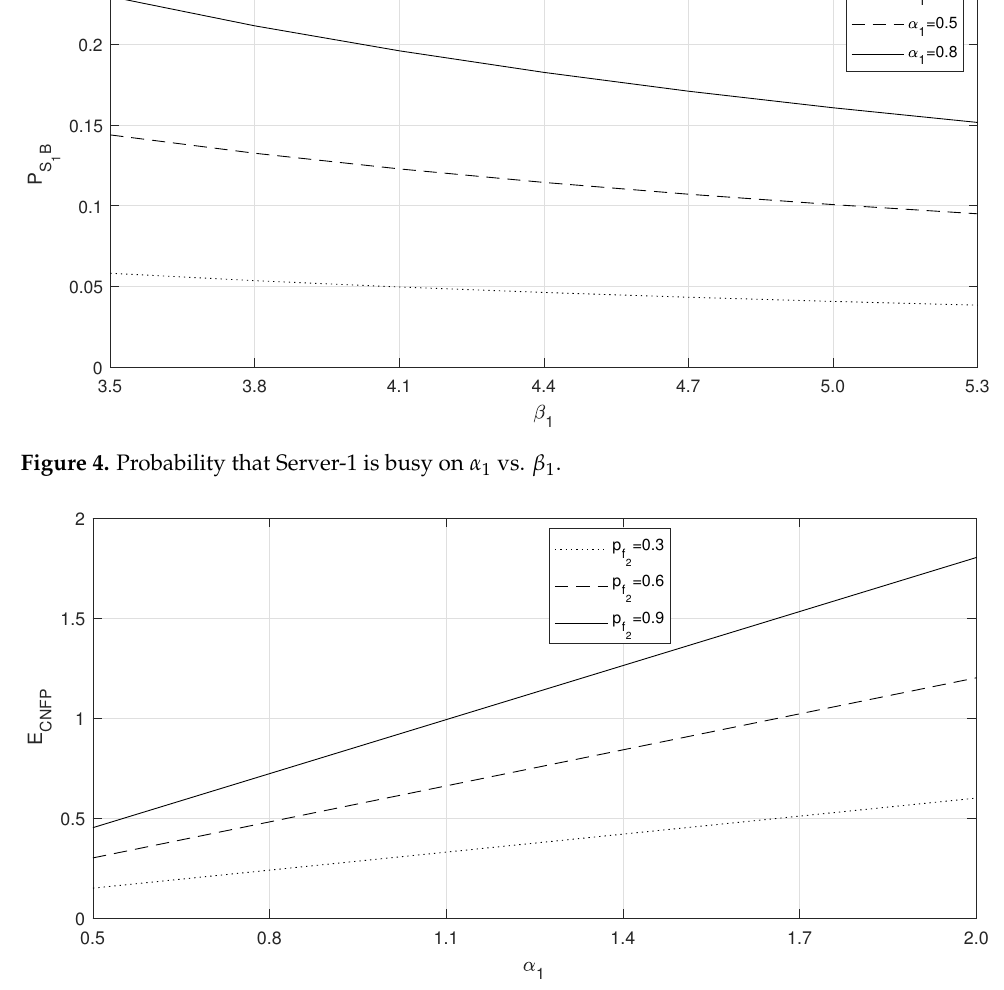
Figure 5. Expected rate at which the customer not purchasing an FP on p f Example 2. Table 1 shows the complete in and out activities of Queue-2. In this example, we see the influence of parameters α 2 and β 2 and the probabilities q r E CNRP , and P S 2 F